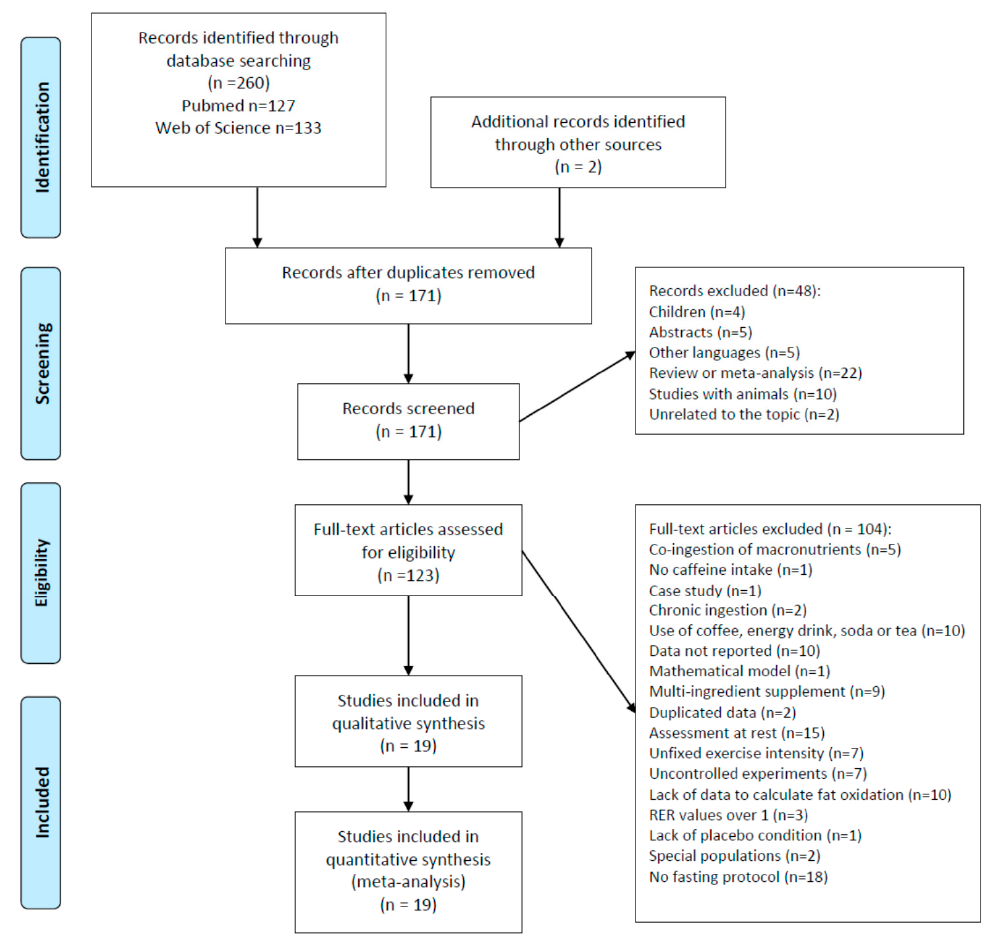
Figure 1. Selection of studies.